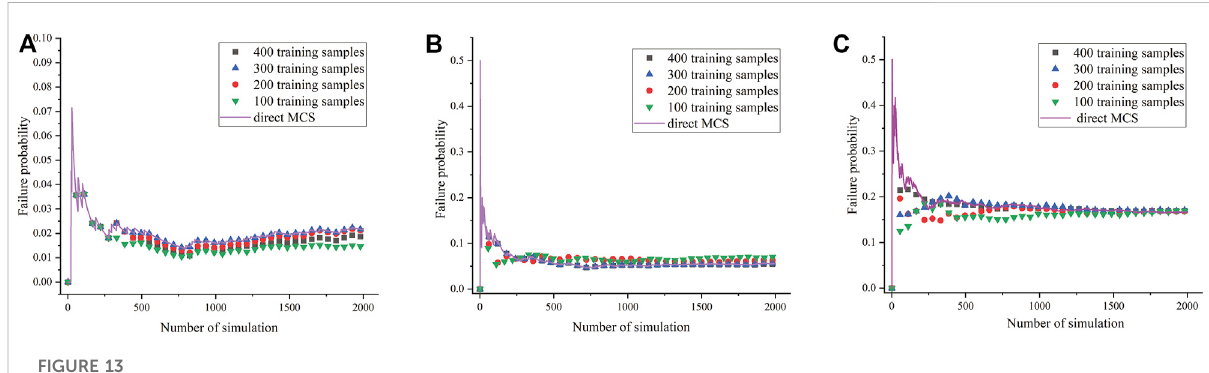
FIGURE 13 Comparison of failure probability for different number of